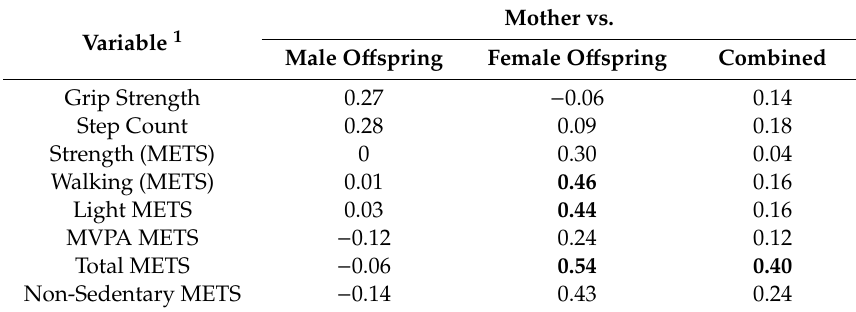
Table 7. Mother–o ff spring correlations for grip strength (combined maximum), steps per day, MET hrs / d per day based on strength related, walking, light and moderate activity categories. Mother vs. Variable 1 Male O ff spring